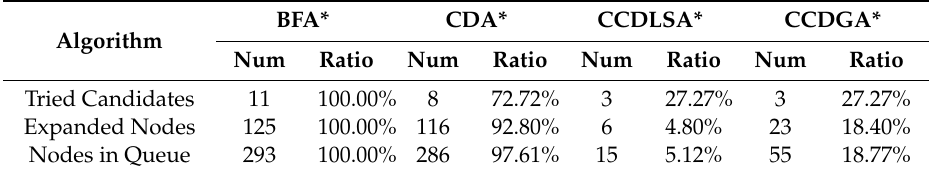
Table 6. Tried Candidates, Expanded Nodes and Nodes in Queue for Single Diagnosis.